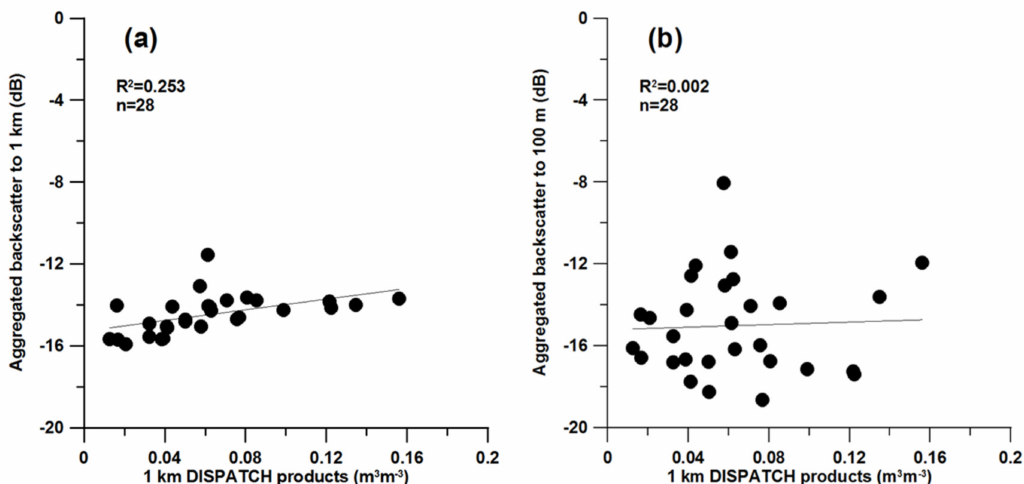
Figure 5. Dependence of the backscatter aggregated to: ( a ) 1 km; and ( b ) 100 m resolutions on the 1 km DISPATCH product.